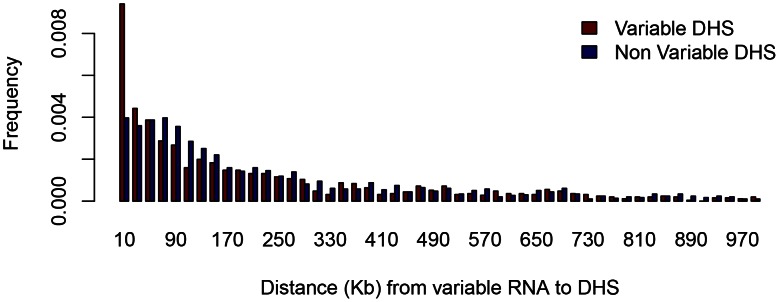
Proximity of DNase I hypersensitive sites to variable RNA.The histogram shows the relative abundance of DHS within one megabase (Mb) of the transcriptional start site of variable RNA species. The horizontal scale is in kilobases (Kb). Variable RNA refers to the 3,472 poly(A)+ transcripts that varied between strains (FDR of 5%). Variable DHS refer to the 1,396 variable peaks (as described in the text), and non-variable refers to 2,849 with least evidence for variation.